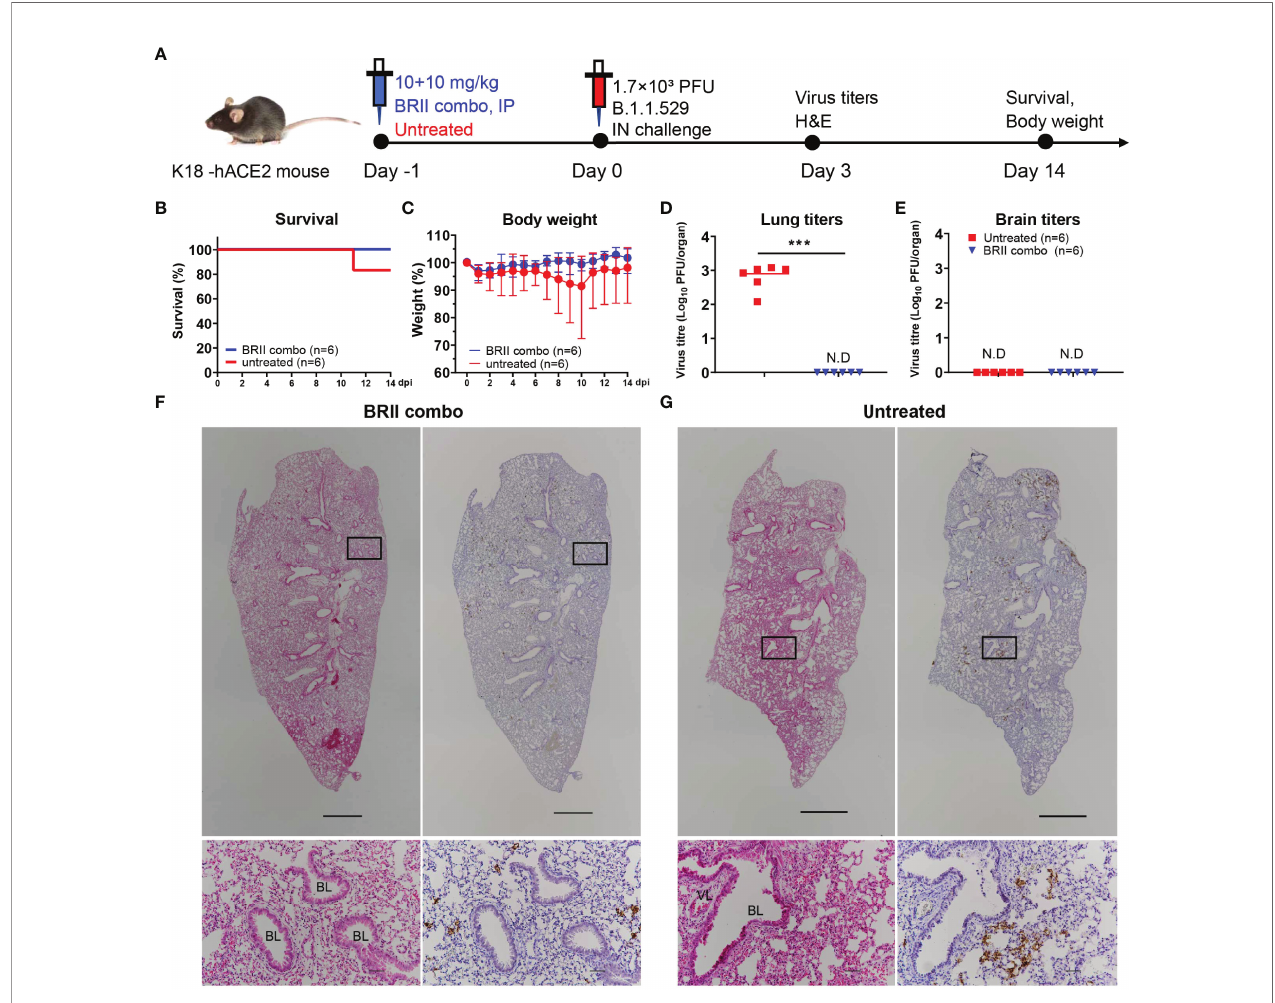
FIGURE 3 | BRII combo protects K18-hACE-2 mice from the infection of authentic SARS-CoV-2 Omicron. (A) Experimental schedule for BRII combo prophylaxis. Eight- week-old K18-hACE2 transgenic female mice were administered with 20 (10 + 10) mg/kg body weight of BRII combo (BRII-196 + BRII-198) intraperitoneally or remained untreated. One day later, all animals were challenged with 1.7×10 3 plaque-forming units (PFU) infectious SARS-CoV-2 Omicron via the intranasal route. (B) The survival percentage and (C) body-weight were recorded daily after infection until the occurrence of death or until the end of experiment. The viral load in (D) the lung and (E) the brain tissues was measured by plaque forming assays in the tissue homogenates at 3 days post inoculation. Data are presented as the means ± SEM. N.D: not detected. Mann- Whitney test was used to analyze statistical signi fi cance. ***P < 0.001. (F, G) H&E and immunohistochemistry staining of lung tissue from BRII combo-treated or untreated mice at 3 days post inoculation. The upper panels show the whole lung sections (5x; Scale bars=1000µm) while the lower panels displayed the enlarged view of the boxed regions (50x; Scale bars=50µm). Dark brown in the enlarged view are SARS-CoV-2 N protein positive cells. VL, vascular lumen; BL, bronchiolar lumen. Images were derived from one representative animal in each